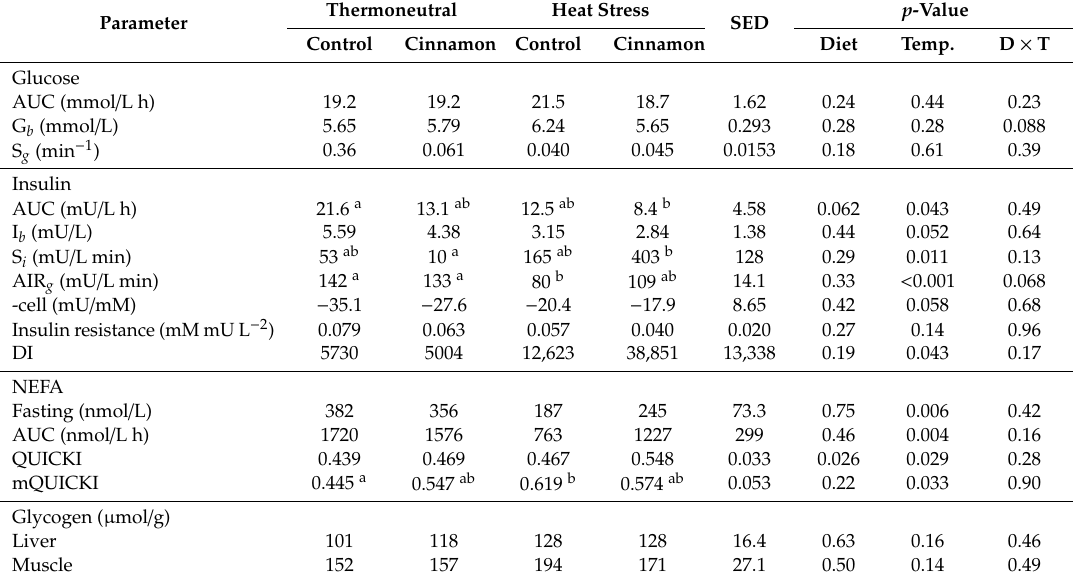
Table 2. The e ff ects of dietary cinnamon (control vs. cinnamon) and temperature (thermoneutral vs. heat stress) on insulin sensitivity as assessed by intravenous glucose tolerance test (IVGTT) and glycogen